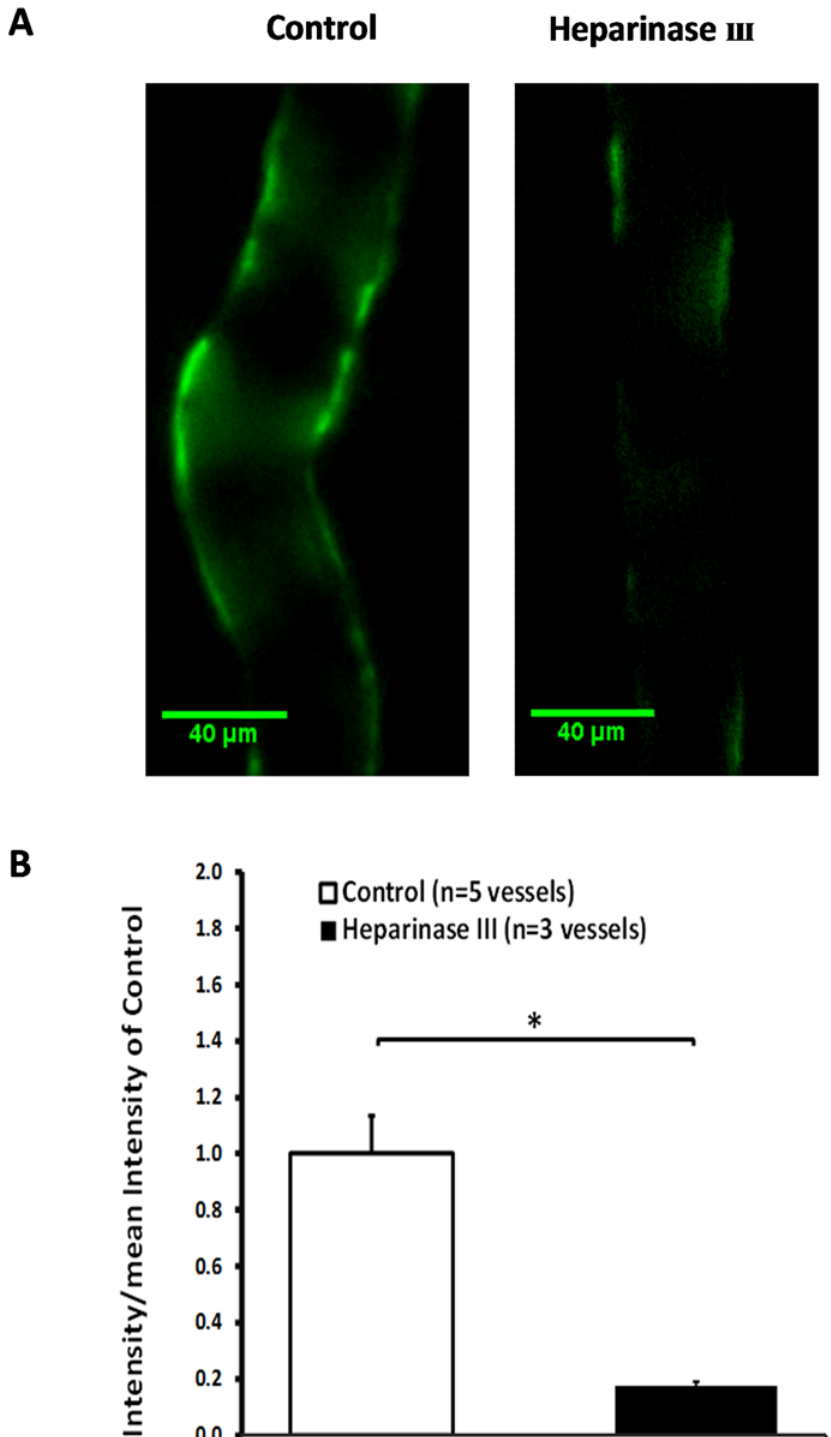
Figure 5. Images of fluorescently labeled heparan sulfate in a control vessel (left in Fig. 5A) and a vessel treated with heparinase III for 1 h (right in Fig. 5A). Fig. 5B shows the comparison of the intensity of the fluorescently labeled heparan sulfate in 5 control vessels and that in 3 heparinase III treated vessels. * p < 0.001.